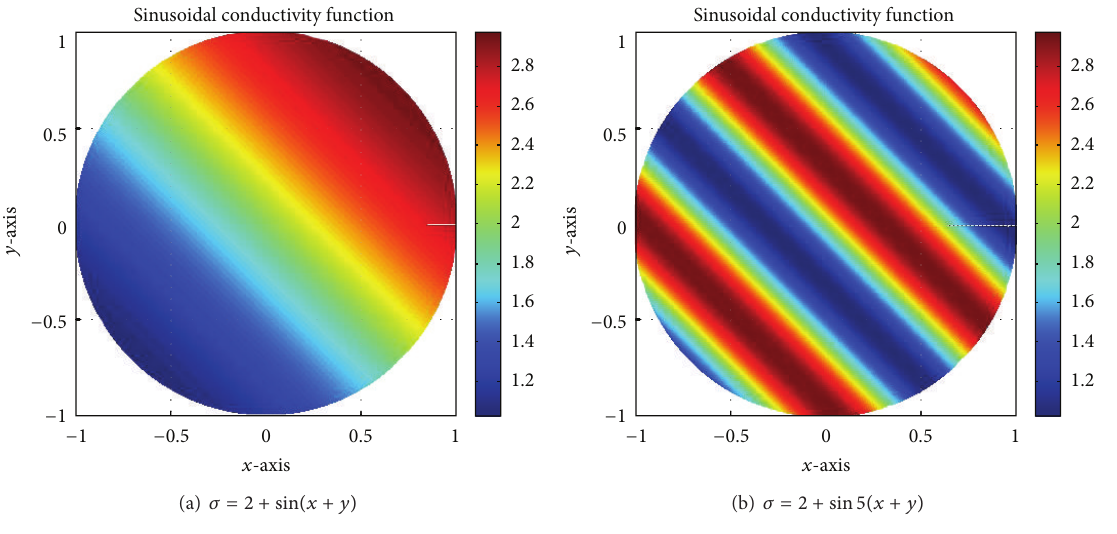
Figure 6: Examples of sinusoidal conductivity functions.